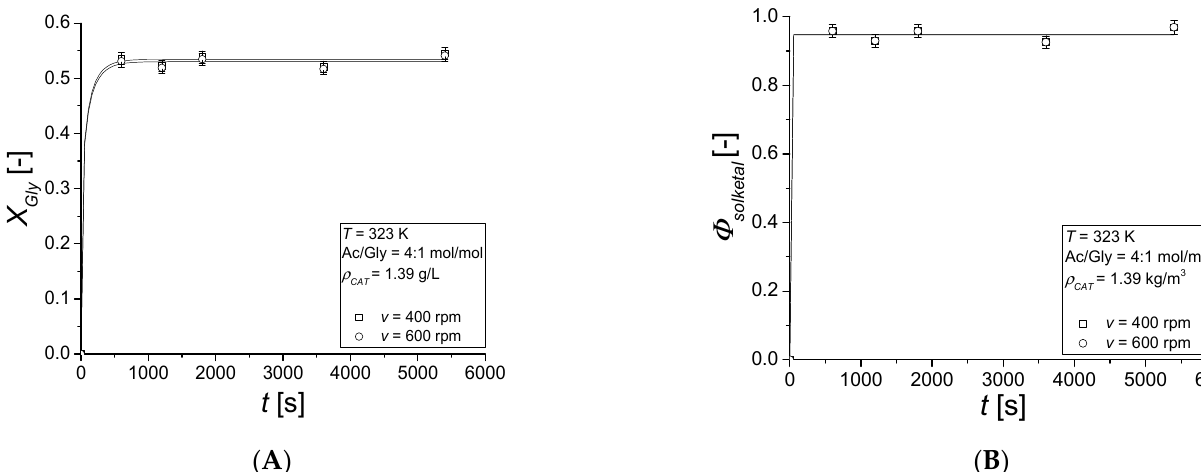
Figure 1. Stirring rate effect for catalyzed tests, fixing T = 323 K, Ac/Gly = 4:1 mol/mol, and ρ CAT = 1.39 kg/m 3 . ( A ) Glycerol conversion. ( B ) Selectivity toward solketal.